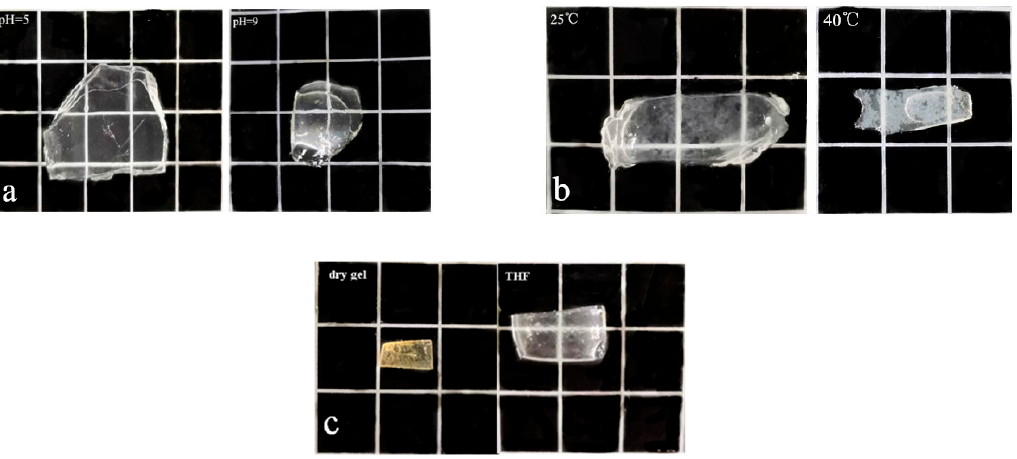
Figure 6. Photographs of gel2 ( a ) 25 °C, pH = 5 and pH = 9, ( b ) pH = 7, 25 °C and 40 °C, ( c ) 25 °C dry gel and swelled gel in tetrahydrofuran (THF).